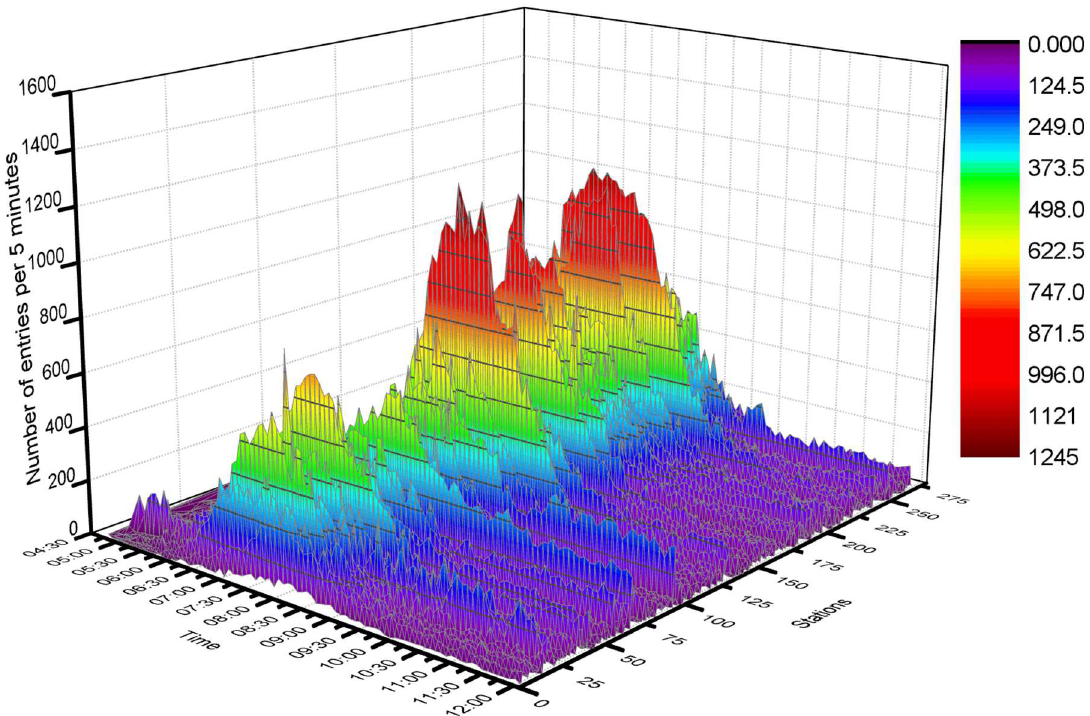
Fig 14. Number of entries in each station every5 minutes. This graph has three dimensions: time, stations and the number of passengers. Every point in a coloredarea donates the entries of a particularstation duringa particularperiod. The color indicatesthe numberof passengers enteringthe